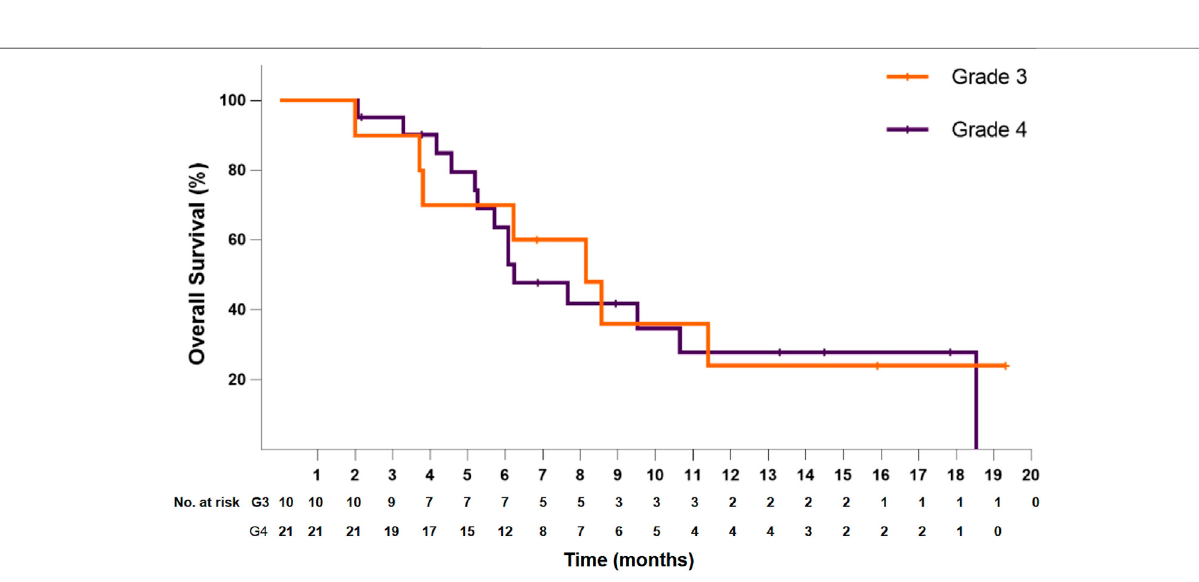
Frontiers in Pharmacology |